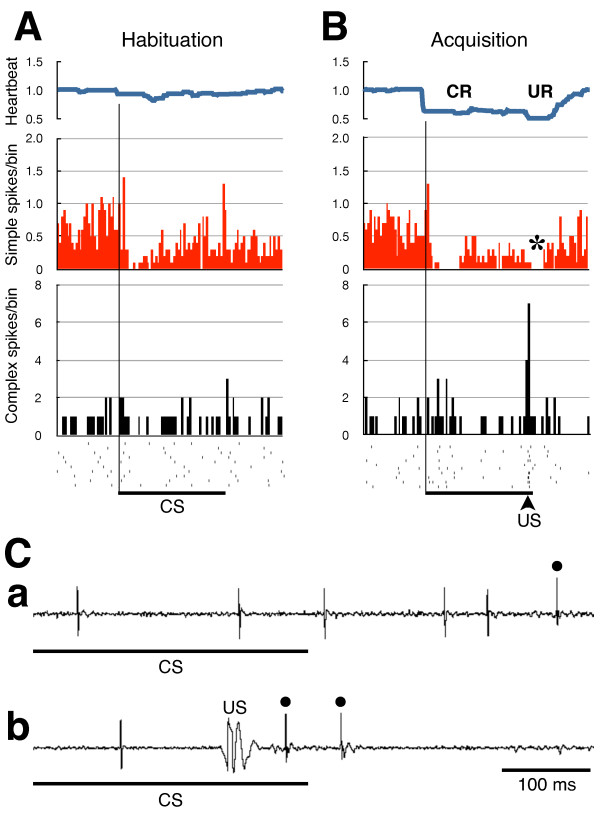
Conditioning-related changes in the simple-spike responses to the CS, and US-evoked complex-spike firings in a PC. Average responses of ten consecutive trials in a habituation session (A) and an acquisition session (B), respectively. Relative heartbeat frequencies relative to the average heartbeat frequencies in the 3 s before the CS are shown. Rastergrams of complex-spike timings are also shown at the bottom. CR: conditioned response; UR: unconditioned response. * denotes a pause in simple-spike firing after the US presentation. The arrowhead indicates the timing of the US presentation. Bin width = 100 ms. C. Representative recordings at the end of the CS in habituation (a) and acquisition (b) sessions. In acquisition session (b), complex spikes (dots) were evoked by US with relatively short latencies. CS: conditioned stimulus; US: unconditioned stimulus. A, B and C were obtained from the same preparation.